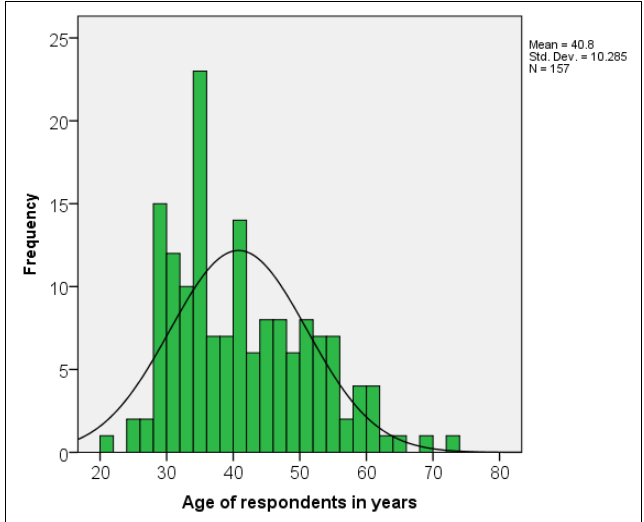
Figure 7: Mean and Standard Deviation of the Respondents’